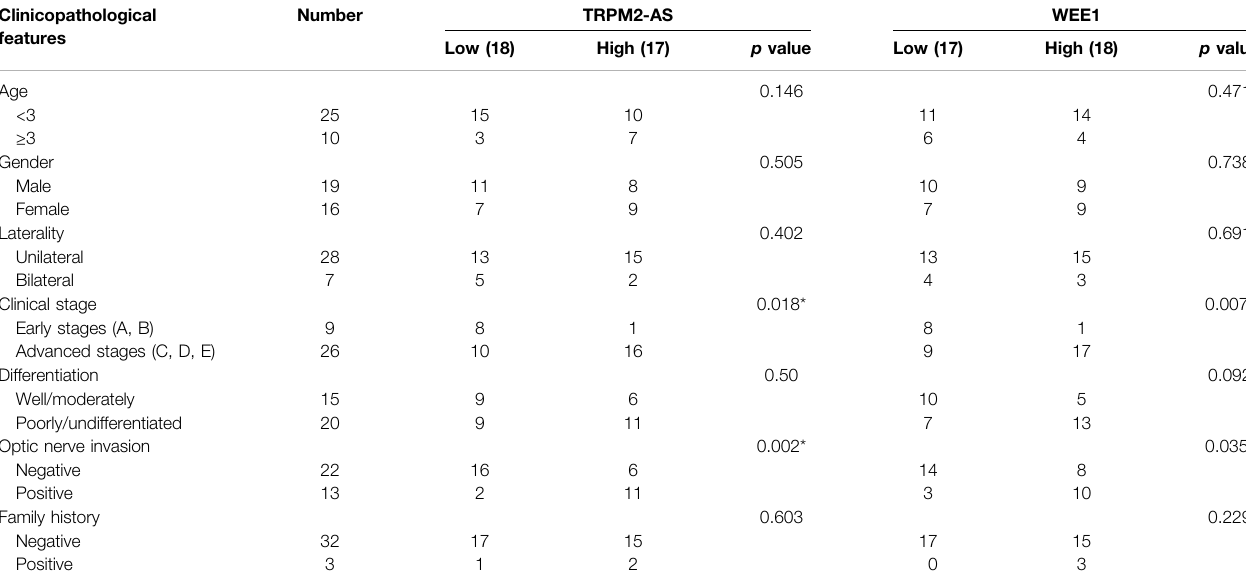
TABLE 1 | Correlation between expression of TRPM2-AS/WEE1 and clinicopathological factor in RB patients. Clinicopathological